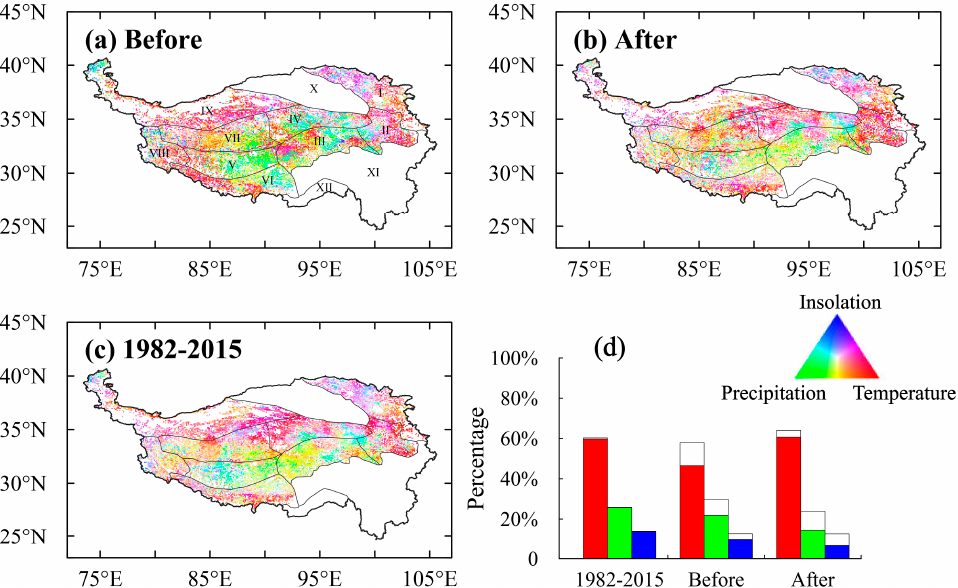
Figure 5. Relative influence of different climate variables (temperature, precipitation, and insolation) on EOS changes before ( a ) and after ( b ) the turning point, and over the entire study period ( c ) with the EOS means values of HANTS and Polyfit methods. ( d ) Area proportions controlled by the different dominant climate variables.